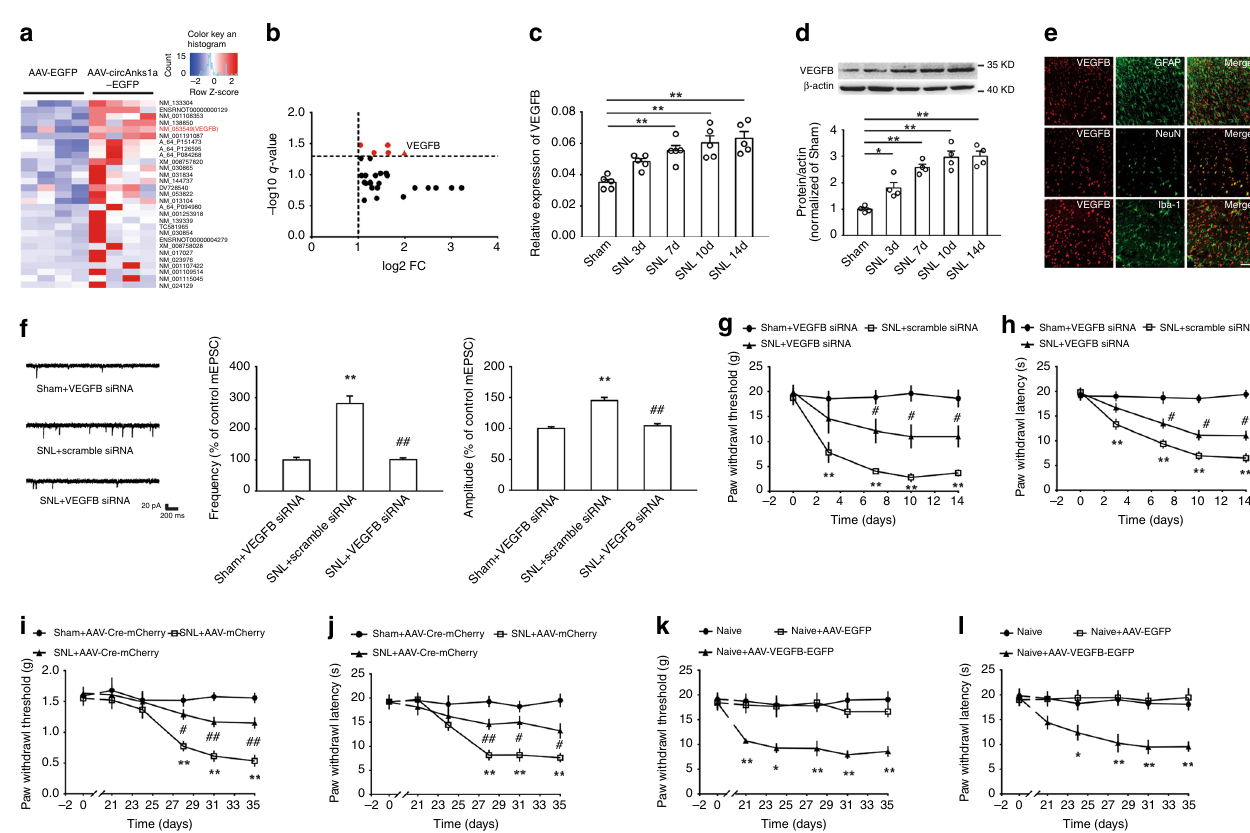
Fig. 4 VEGFB in the spinal dorsal horn contributed to neuropathic pain following SNL. a Heat map showed the signi fi cantly upregulated mRNAs in the dorsal horn of AAV-circAnks1a-EGFP-injected rats ( n = 4). b Volcano map showing that VEGFB has the maximum increased fold with q < 0.05 ( n = 4). c , d The mRNA and protein levels of VEGFB in the dorsal horn of rats were measured at various time points following SNL ( * P < 0.05, ** P < 0.01 vs. the sham group, two-tailed one-way ANOVA, n = 5 for ( c ) and n = 4 for ( d )). e Immuno fl uores c ence staining of VEGFB (red) colocalized with NeuN (neuron marker, green) but not with GFAP (astrocyte marker, green) or Iba-1 (microglial marker, green). Scale bar, 50 μ m ( n = 3). f VEGFB siRNA treatment (1 nmol 10 µ l − 1 , i.t.) ameliorated the increase in the amplitude and frequency of mEPSCs on day 14 following SNL ( ** P < 0.01 vs. the sham group, ## P <0.01 vs. the corresponding scramble group, two-tailed one-way ANOVA for amplitude, two-tailed permutation tests for frequency, n = 24). g Intrathecal injection of VEGFB siRNA attenuated the mechanical allodynia induced by SNL ( ** P < 0.01 vs. the sham group, # P < 0.05 vs. the corresponding scramble group, two-tailed permutation tests, n = 12). h The effect of VEGFB siRNA on withdrawal latency ( ** P < 0.01 vs. the sham group, # P < 0.05 vs. the corresponding scramble group, two-tailed permutation tests, n = 12). i , j Local knockdown of VEGFB by intraspinal injection of AAV-Cre-mCherry into VEGFB fl ox/ fl ox mice s i gni fi cantly ameliorated mechanical allodynia and thermal hyperalgesia ( ** P < 0.01 vs. the sham group, # P < 0.05, ## P < 0.01 vs. the corresponding AAV-mCherry group, two-tailed permutation tests, n = 8 for ( i ) and n = 12 for ( j )). k , l Intraspinal injection of AAV-VEGFB-EGFP signi fi cantly reduced the withdrawal threshold and withdrawal latency 21 days after injection ( * P < 0.05, ** P < 0.01 vs. the corresponding AAV-EGFP group, two-tailed permutation tests, n = 12). The data are presented as the mean ± s.e.m. Source data is available as a Source Data fi le